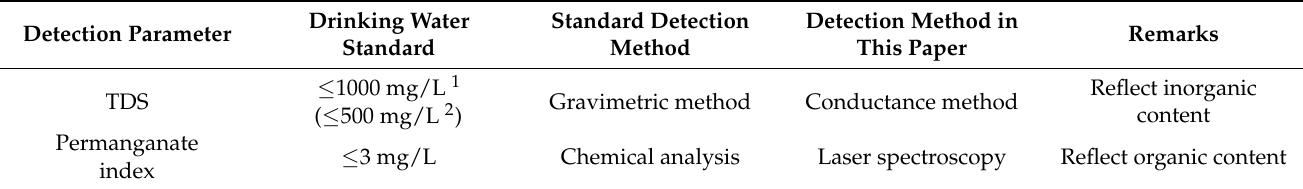
Table 1. Comparison between the detection method in this paper and the standard detection method in